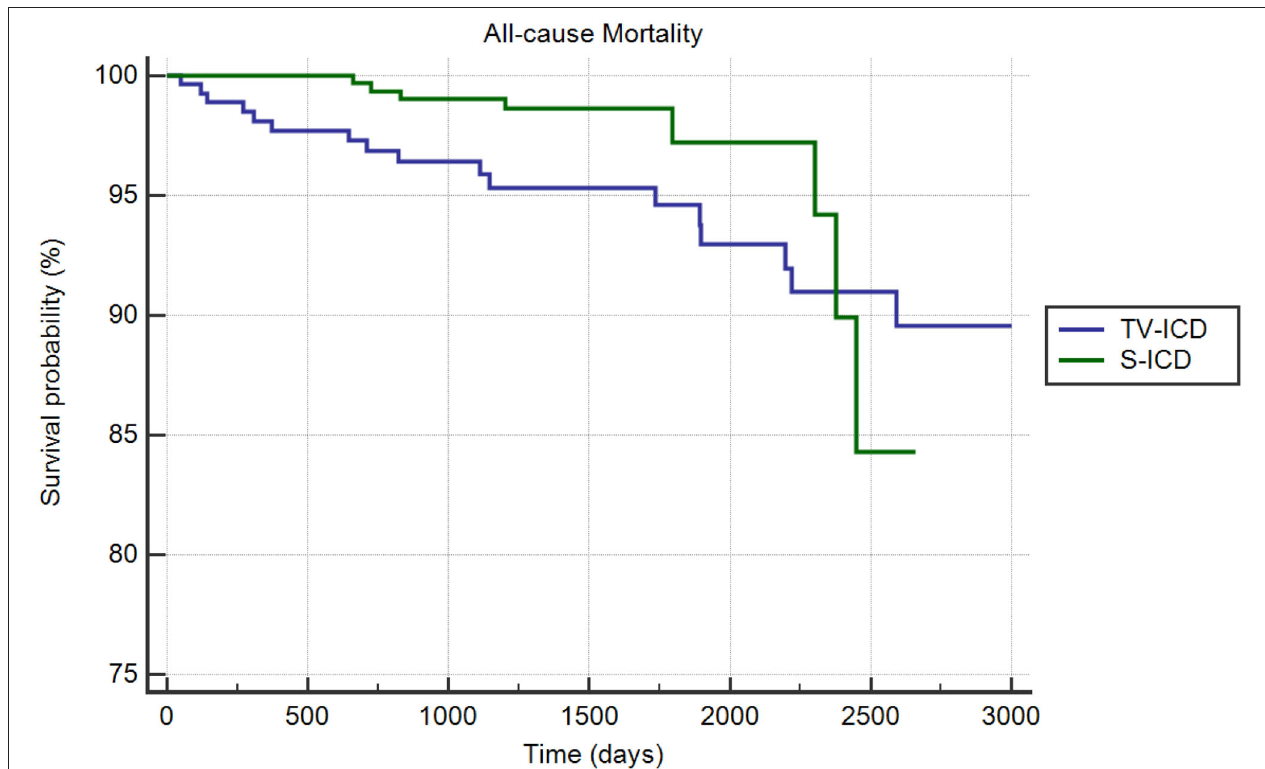
FIGURE 4 | Kaplan-Meier curve comparing survival without all-cause mortality among S-ICD vs. TV-ICD groups.